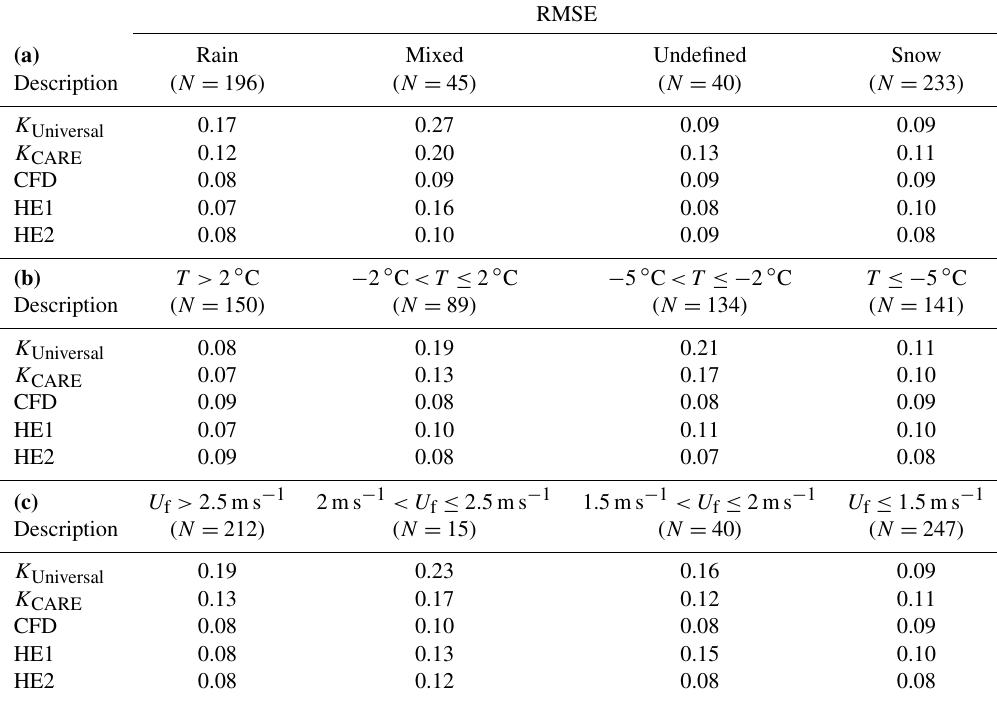
Table 4. Unshielded gauge 30min event collection efficiency RMSE results stratified by (a) POSS precipitation type, (b) temperature, and (c) fall velocity. Results are shown for K Universal transfer function with wind speed and air temperature dependence, K CARE transfer function with wind speed and air temperature dependence, present study CFD transfer function with wind speed and mode fall velocity dependence, HE1 transfer function with wind speed and mean fall velocity dependence, and HE2 transfer function with wind speed and mode fall velocity dependence. Statistics are based on the comparison of experimental results from the CARE site between 1 November and 30 April 2013/14 and